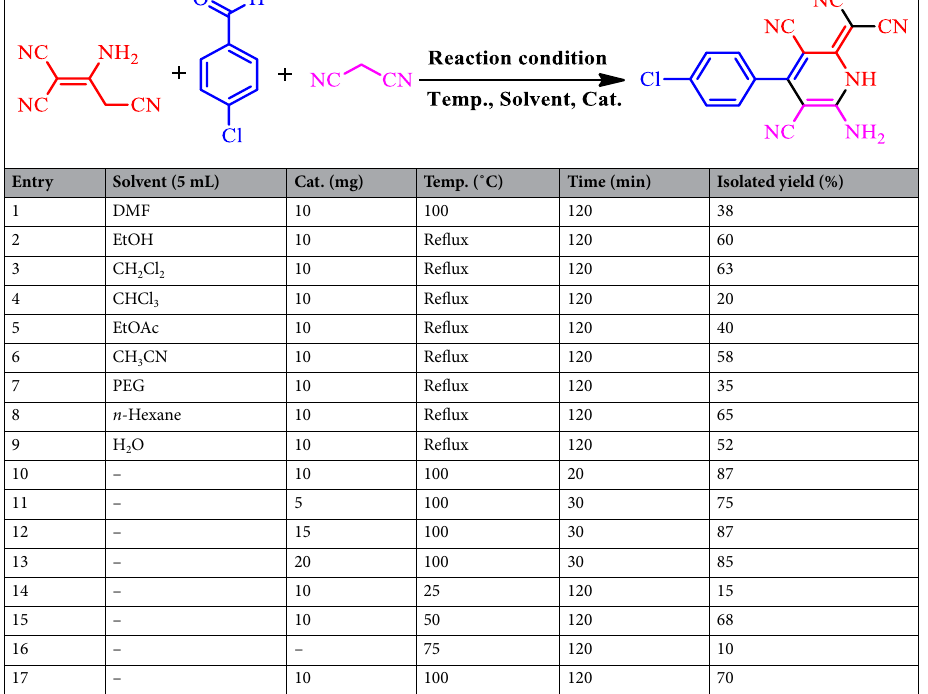
Table 4 indicates the results of the model reactions based on the electronic properties of substitute groups on the benzaldehyde. The data presented in Table 4 shows the applied procedure have a satisfying performance for electrosynthesis of related dihydropyridine derivatives in a one-pot reaction with a 63–85% overall yield. It is noteworthy to mention that, the higher product yield for aldehydes with electron-withdrawing groups, 4-Chlorobenzaldehyde, is comparable and even greater than that of their simple (benzaldehyde) and/or electron- donating (4-methylbenzaldehyde) group homologues. These results may be caused by more efficient deproto- nation of related aldehydes bearing electron-withdrawing groups lead to an intermediate under the proposed mechanism. So, the obtained trend may be repeated for the other homologue aldehydes based on the electron characteristics of substituted groups with acceptable tolerance. To evaluate the performance of [Zr-UiO-66-PDC-SO 3 H]Cl as an efficient catalyst for the synthesis of dicy- anomethylene pyridine, we have tested different acid catalysts (organic and inorganic) by reaction of 4-chloro benzaldehyde (1.0 mmol, 0.14 g), 2-aminoprop-1-ene-1,1,3-tricarbonitrile (1.0 mmol, 0.132 g), and malononi- trile (1.1 mmol, 0.072 g) in Table 5. As a result in Table 5, [Zr-UiO-66-PDC-SO 3 H]Cl is the best catalyst for the synthesis of dicyanomethylene pyridine.